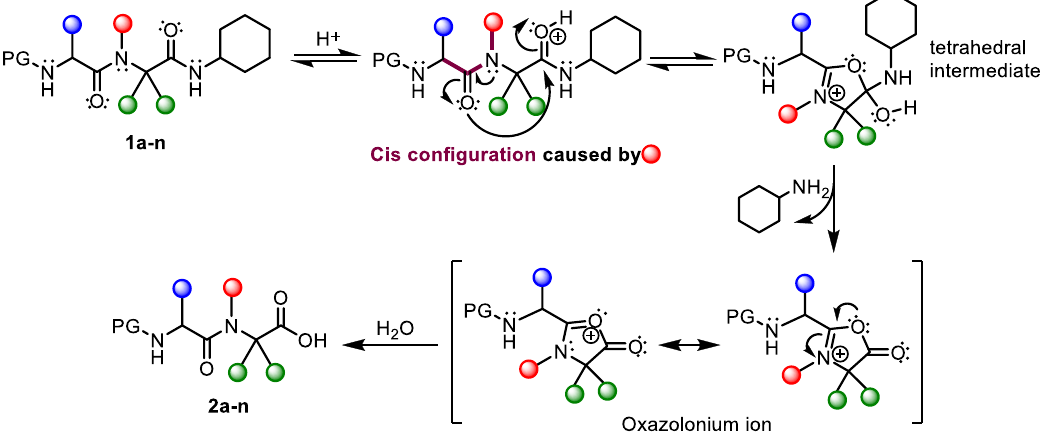
Figure 3. Acidolysis of N -alkylated α , α -dialkylglycine ( 1a – n ) to give ( 2a – n ) and the corresponding C-terminal amide cleavage reaction mechanism via oxazolonium ion intermediate. Table 1. Acidolysis results.